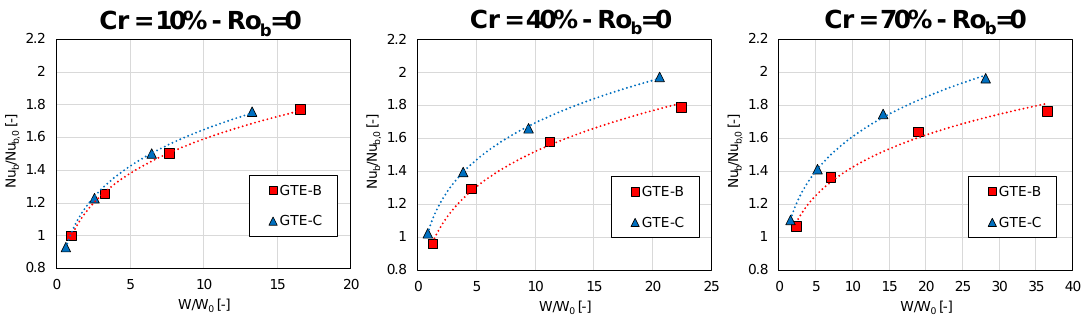
Figure 7. Nu b area averaged values as a function of pumping power for static